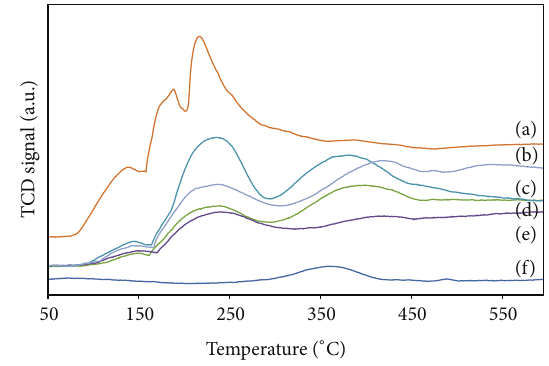
Figure 6: NH 3 -TPD profiles of (a) pure Ppy and WO 3 -Ppy with particle loadings of (b) 20, (c) 15, (d) 10, (e) 5 wt%, and (f) WO 3 NPs,